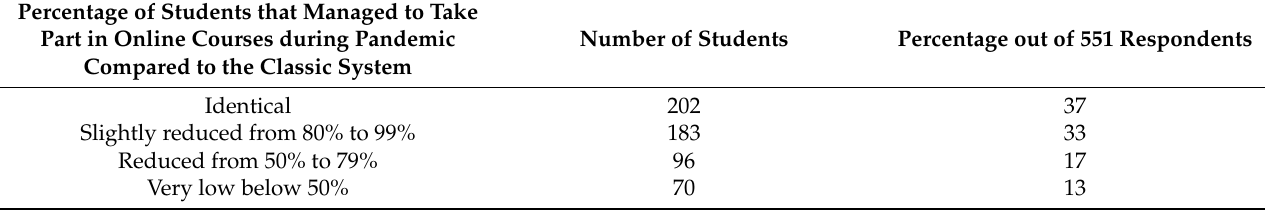
Table 9. The percentage of which students managed to take part in courses during the pandemic compared to the participation in the classic version, in the pre-pandemic (question 4). Percentage of Students that Managed to